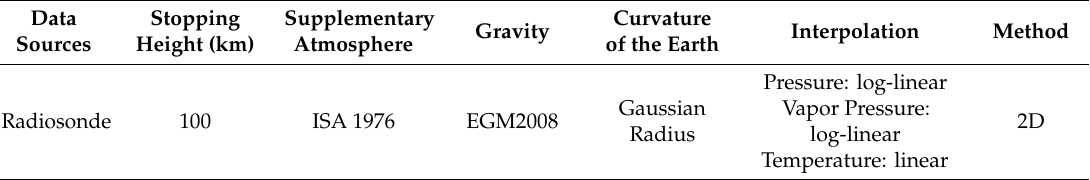
Table 4. Details of the ray-tracing algorithm used in this